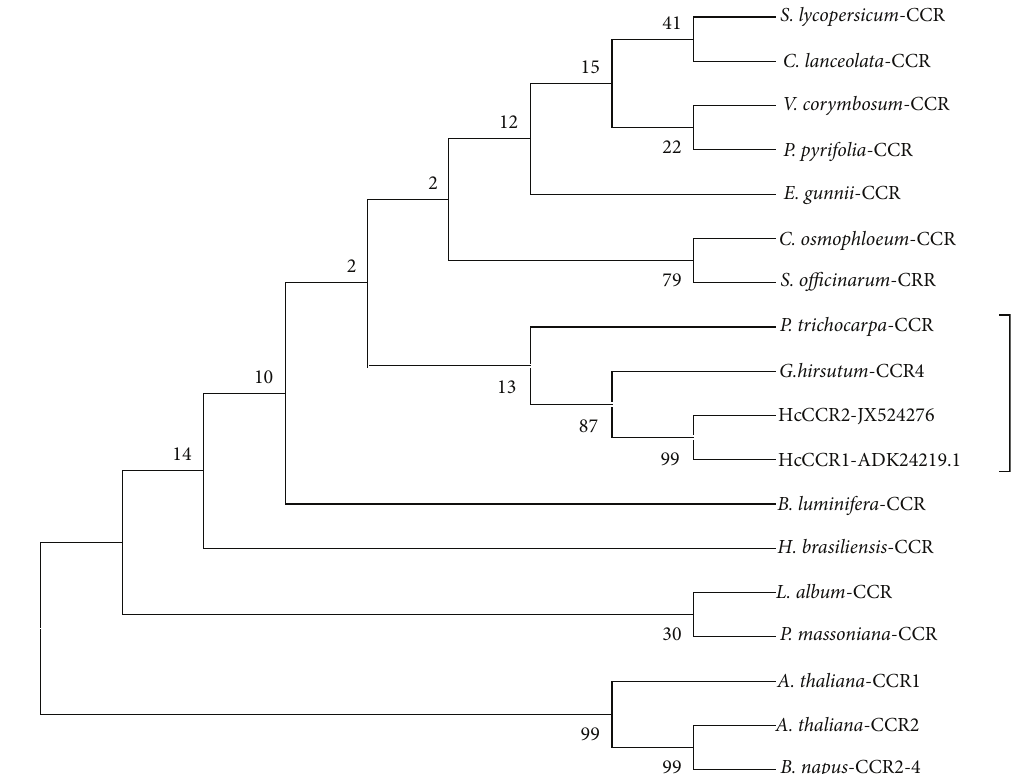
Figure 4: Phylogenetic analysis of the deduced amino acid sequences of kenaf CCR ortholog and other plants. The tree was constructed by the neighbor-joining method of ClustalW and Mega5. The numbers at the nodes indicate bootstrap values from 1000 replications. GenBank accession numbers are represented as follows: Solanum lycopersicum (NP001234612), Codonopsis lanceolata (BAE48787), Vaccinium corymbosum (ACI14382), Pyrus pyrifolia (ADK62523), Eucalyptus gunnii (CAA56103), Cinnamomum osmophloeum (AFG26325), Saccharum officinarum (CAA13176), Populus trichocarpa (CAC07424), Gossypium hirsutum (ACQ59094), Hibiscus cannabinus (JX524276), Hibiscus cannabinus (ADK24219), Betula luminifera (ACJ38670), Hevea brasiliensis (ADU64758), Linum album (CAD29427), Pinus massoniana (ACE76870), Arabidopsis thaliana (NP173047), Arabidopsis thaliana (AAG53687), and Brassica napus